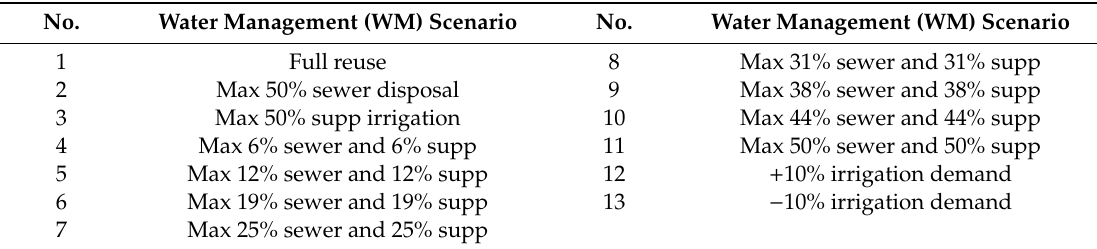
Table 2. Water management